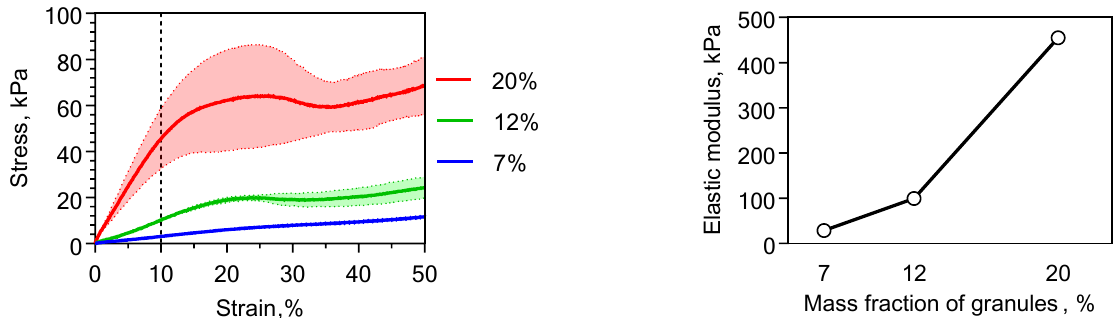
Figure 2. Mechanical properties of composition based on the chitosan and β -glycerophosphate hydrogel and the PLA granules. ( Left ) The deformation curves of the composite materials during compression test. ( Right ) The elastic modulus of the compositions containing different PLA granule mass fractions.